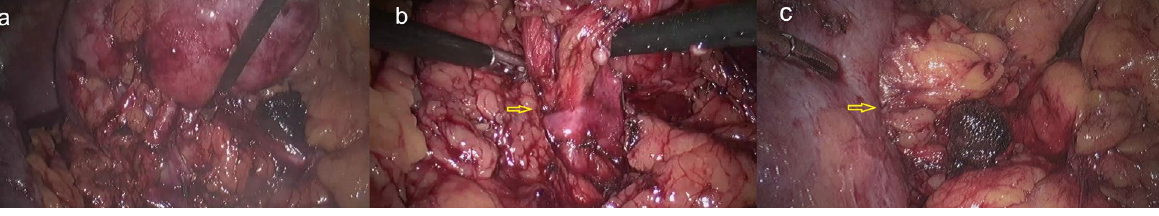
Fig. 2 a Left kidney after complete defatting. b Completely dissected left renal hilum (marked with yellow arrow). c Partially exophytic left renal tumor (marked with yellow